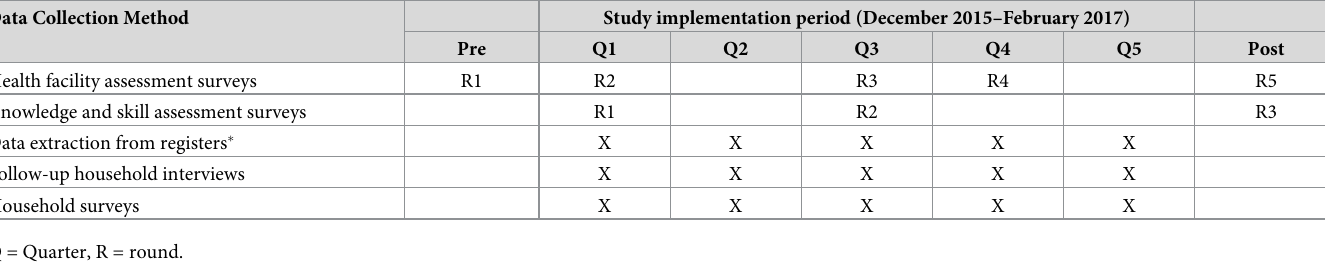
Table 1. Data collection timeline by data collection